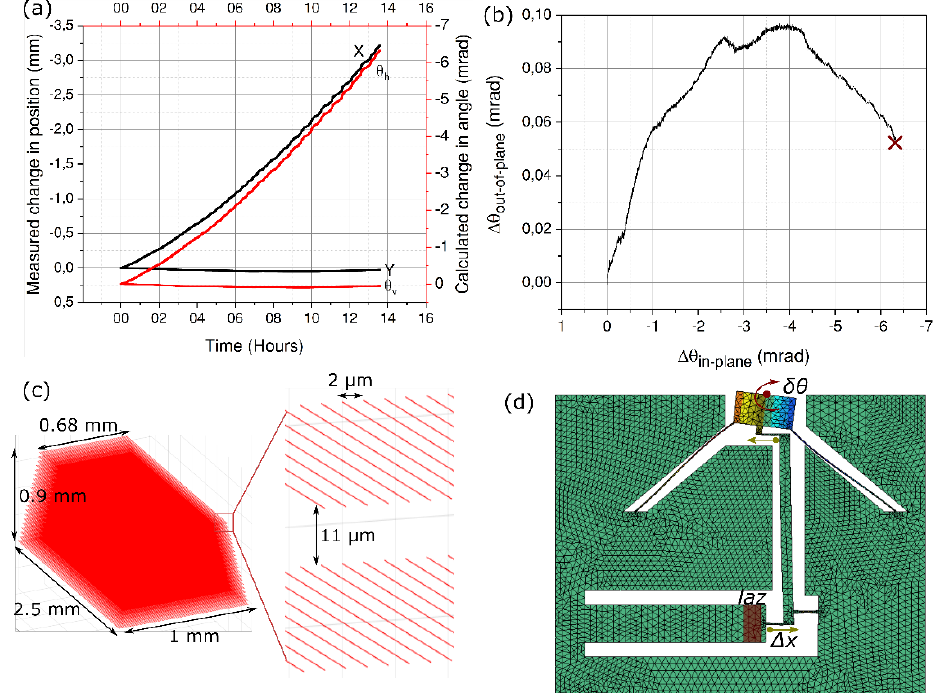
Figure 8. ( a ) Experimental observation of the laser beam spot on the detector surface when the actuator is exposed to long pulses at τ = 300 fs. ( b ) Out-of-plane bending angle vs. the in-plane angle of rotation. ( c ) A 3D representation of a single laser affected zone used in all the experiments. In the inset, two vertically separated planes containing the lines are shown. ( d ) The exposure configuration. The direction of strain is reversed here as is pointed by the arrows.